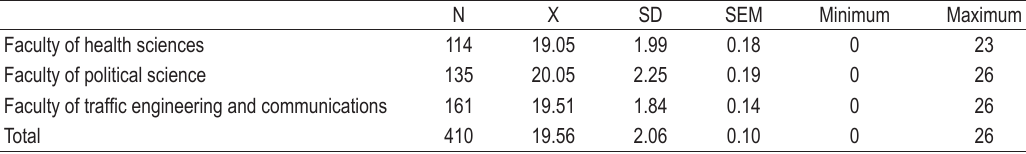
TABLE 2. Average age of students in three groups